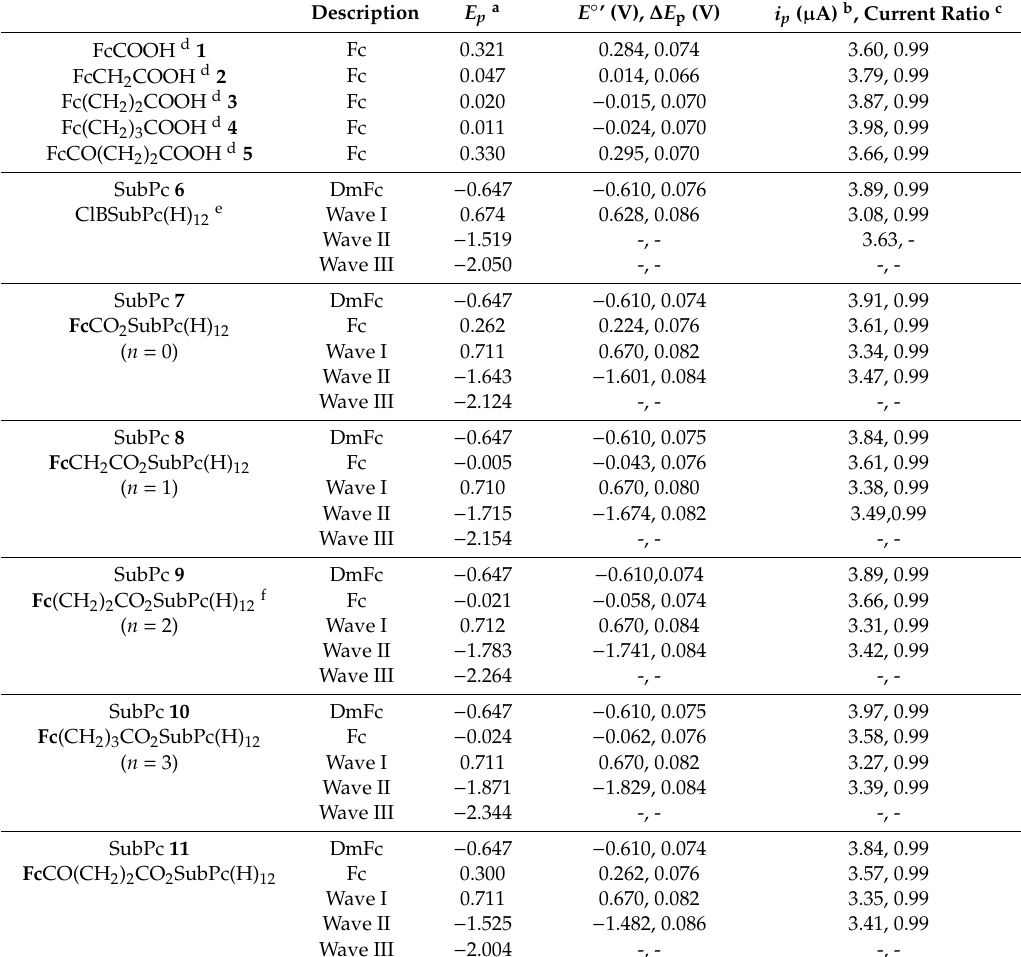
Table 2. Cyclic voltammetry data of ligands 1 – 5 and SubPcs 6 – 11 in DCM containing 0.1 mol dm −